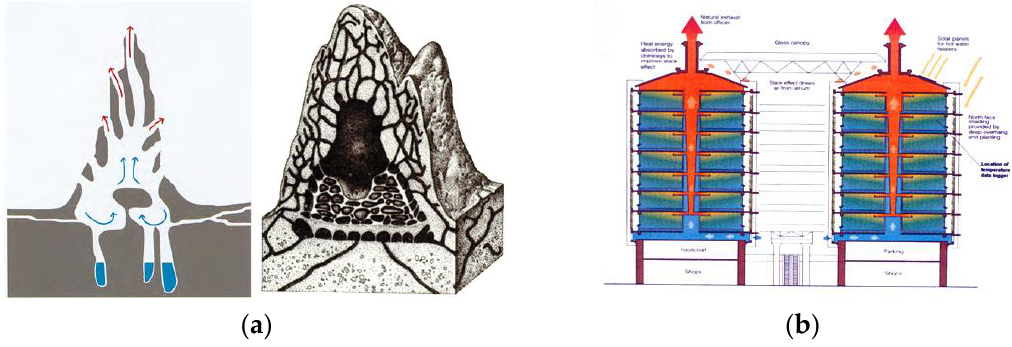
Figure 5. ( a ) The architecture of termite mound [38]; ( b ) The Eastgate Centre, Harare [39].